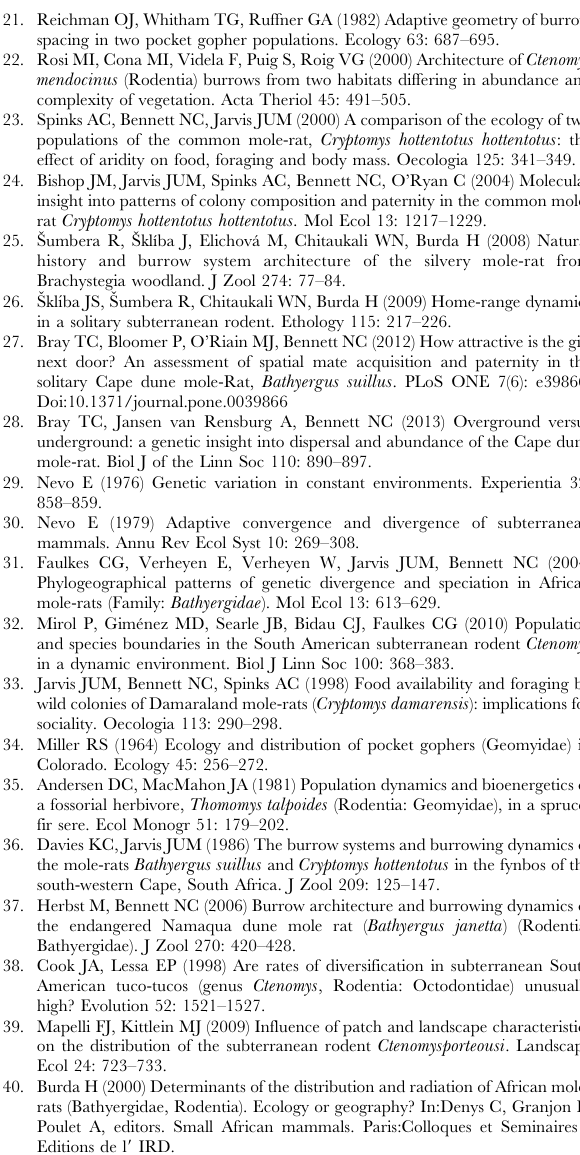
Table S1 Summary information for the microsatellite loci used in this study. Locus summary information showing the estimated proportion of null alleles (Null), percentage missing data of the total 356 alleles/locus, proportion of missing alleles/ locus, the genotyping error per genotype and F IS values for each of the microsatellite loci used in this study. Table S2 Summary of loci which did not conform to Hardy-Weinberg Equilibrium in each population. Sum- mary of loci which did not conform to Hardy-Weinberg